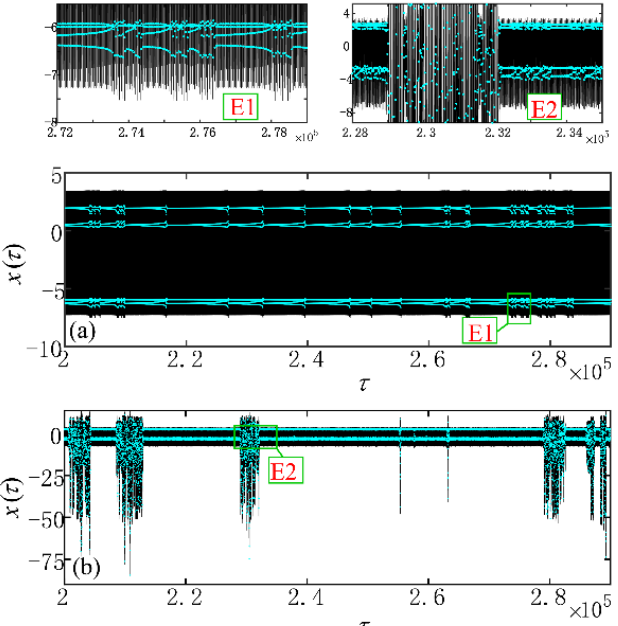
Figure 10. Time series x ( τ ) and their enlargements of one-sided contact system for ω = 1, ( a ) A = 1.78, and ( b ) A = 1.785, where the cyan dots denote the period-1 mapping points of x ( τ ) at intervals of excitation period 2 π .